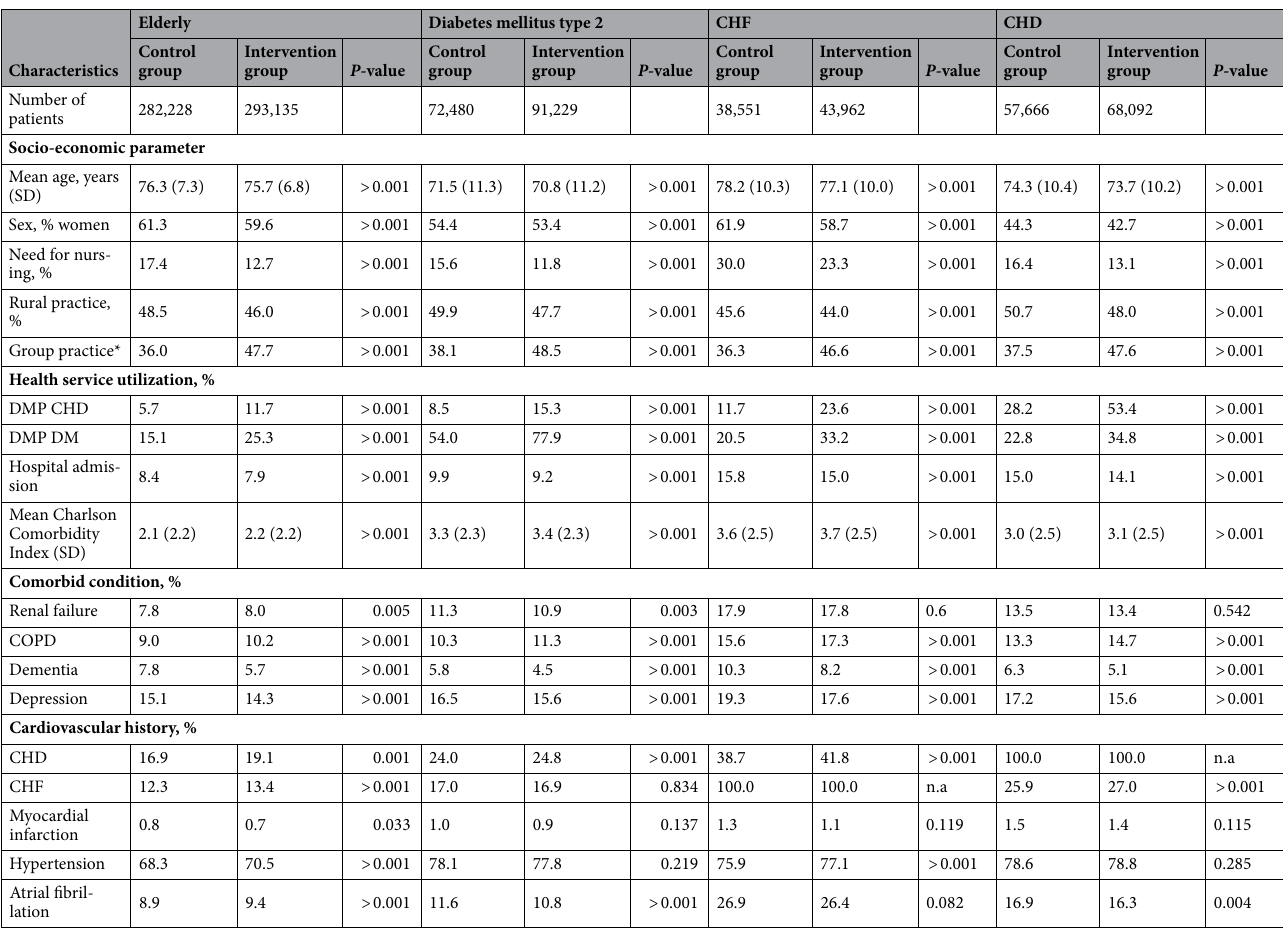
Table 2. Characteristics of patients by group in two of the final three quarters of 2011. CHF chronic heart failure, CHD coronary heart disease, COPD chronic obstructive pulmonary disease, DMP disease management program, DM diabetes mellitus, SD standard deviation. *Doctors working in a group